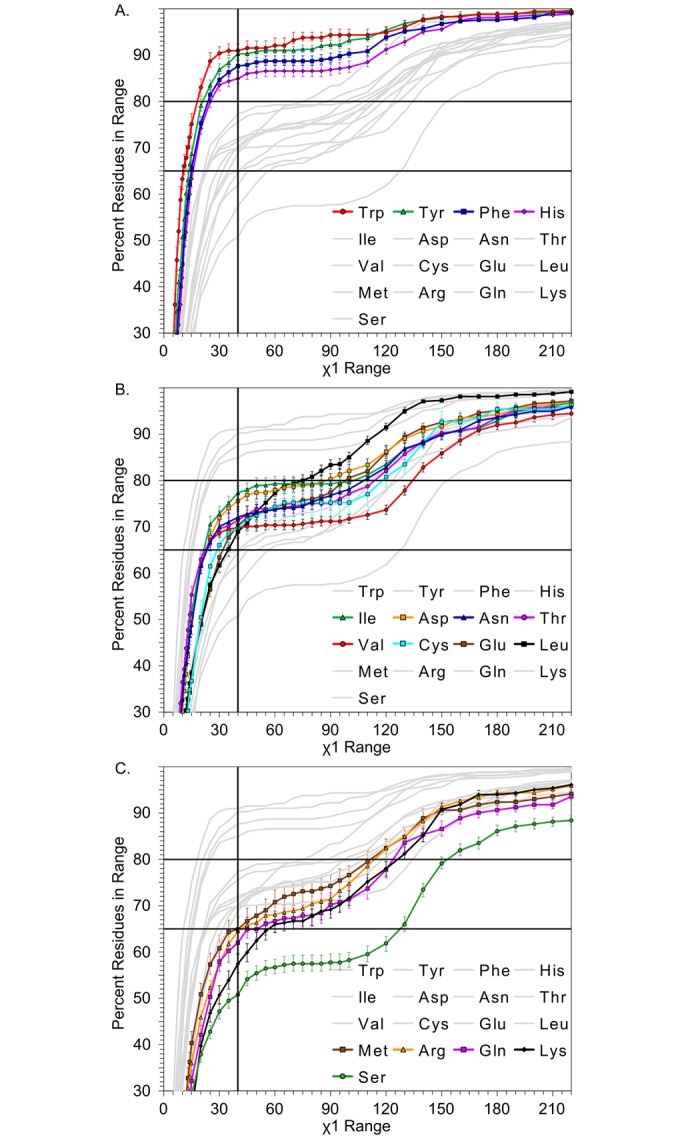
Cumulative distributions of binding-site χ1 ranges for each type of amino acid.The data describes the flexibility of different amino acids as a gradient of rotameric state change. Separated into three groups: A) rigid residues, B) semi-flexible residues, and C) very flexible residues. Error bars represent 95% confidence intervals.